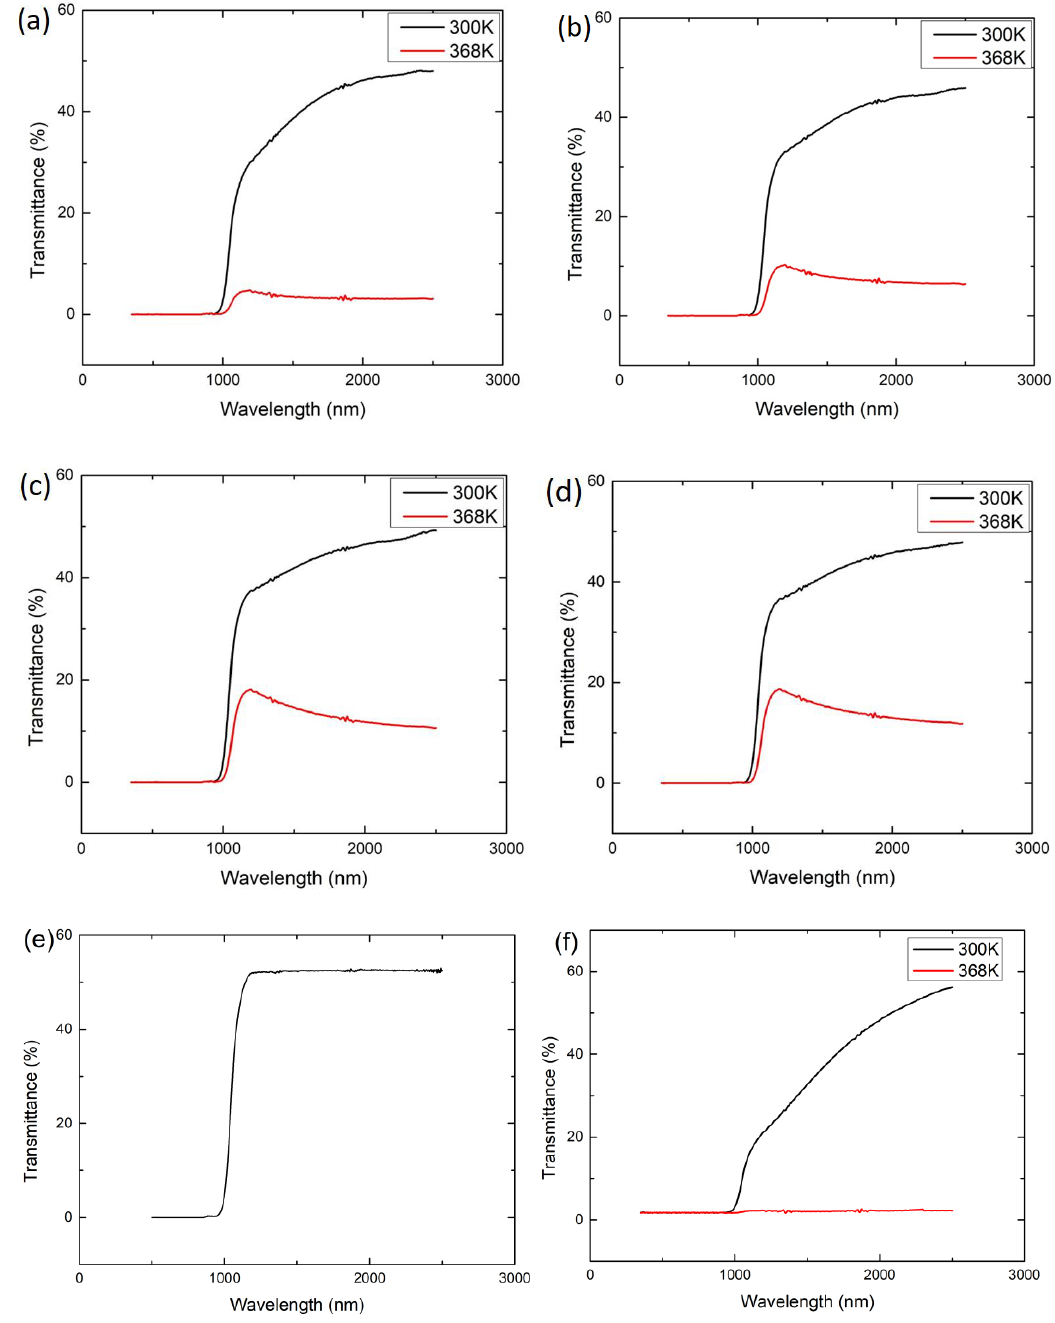
Figure 4. Optical transmittance of the as-deposited VO 2 thin films with a substrate bias voltage of: ( a ) 89 V; ( b ) 126 V; ( c ) 146 V; ( d ) 173 V; ( e ) bare Si substrate; ( f ) no bias (data extracted from reference [23] and replotted).